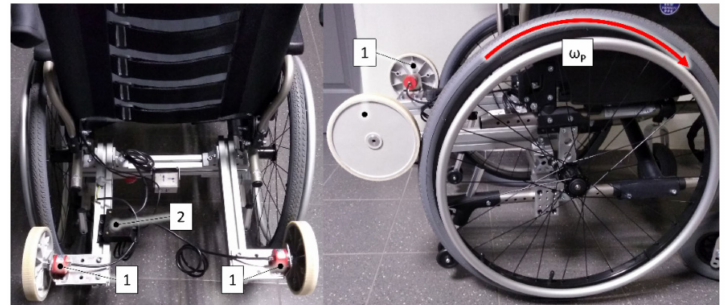
Figure 3. A wheelchair with the test apparatus for measuring its motion kinematics, where: 1—incremental encoder with the resolution of 500 steps, a central unit collecting a measurement signal, 2—a central unit collecting a measurement signal. Selected symbol ω P is the angular velocity of the right wheel of the wheelchair.